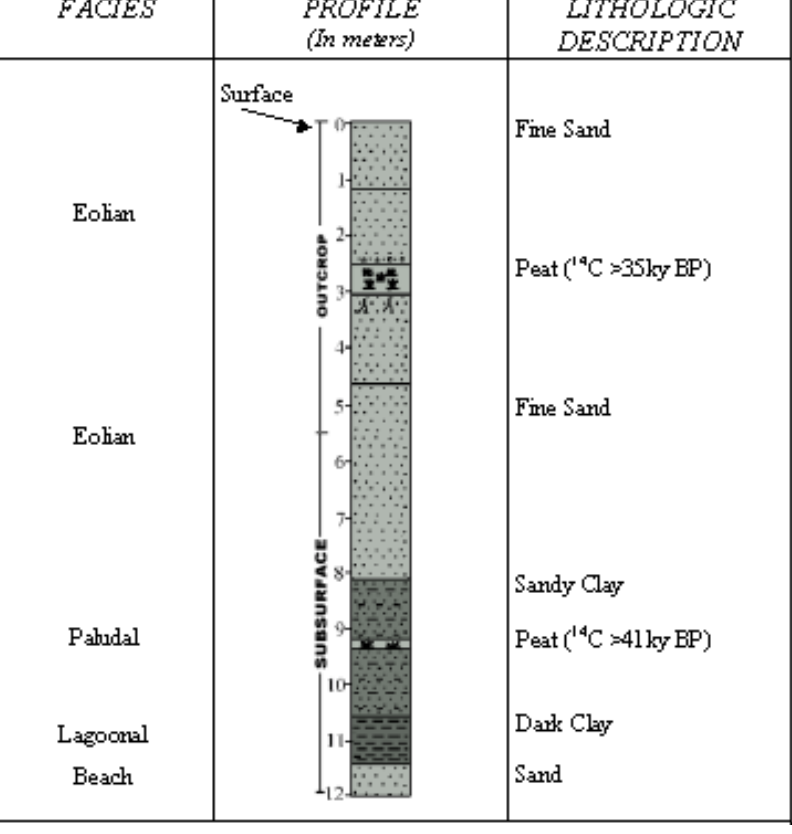
Fig. 5 – Drilling profile integrated with the outcrop data in Guaiúba Beach (28 ◦ 17’10”S/ 48 ◦ 42’07”W). (See geological map – Drilling